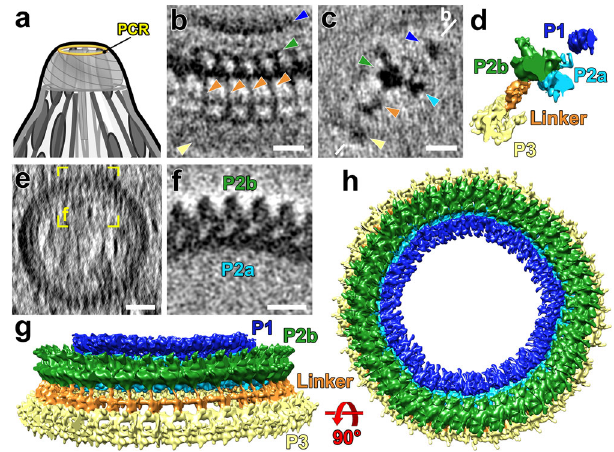
Fig. 5 | Subtomogram averages of the PCRs show three rings and a linker. a Cartoon of the apical complex highlighting the location of the PCRs. b – d Tomographic slices ( b and c ), and isosurface rendering of the averaged PCR repeats ( d ) viewed in the tangential ( b ) and longitudinal ( c and d ) orientations, showing different components of the PCR including the apical P1 (highlighted by blue arrowheads), P2a (cyan), P2b (green), P3 (yellow), and the linker (orange) between P2b and P3. The white line in ( c ) indicates the location of the slice in ( b ). e , f Cross-sectional slices from a raw tomogram ( e ) and the averaged PCR repeats ( f )showthatthe round PCR P2 ring is composed ofanouter and aninner ring,P2a and P2b, respectively. The yellow square in ( e ) indicates the orientation and loca- tion of the subtomogram average displayed in ( f ). g , h Isosurface renderings show the complete PCRs byassembling the averaged repeatsbackto the fulltomogram. Scale bars, 20nm (in b , c , f ); 50nm (in e ). (Fig. 4f and Supplementary Fig. 6e, e ’ ). To determine the structural polarity of the conoid fi ber, we performed a ninefold average of the proto fi laments (using the tangential/normal to the C-shape curvature of the fi ber). The isosurface rendering of the ninefold averaged pro- to fi lamentsdisplayeda “ clockwiseskew ” whenviewedfromtheconoid base, suggesting the minus ends of the conoid fi bers are located at the base of the conoid complex (Fig. 4g).